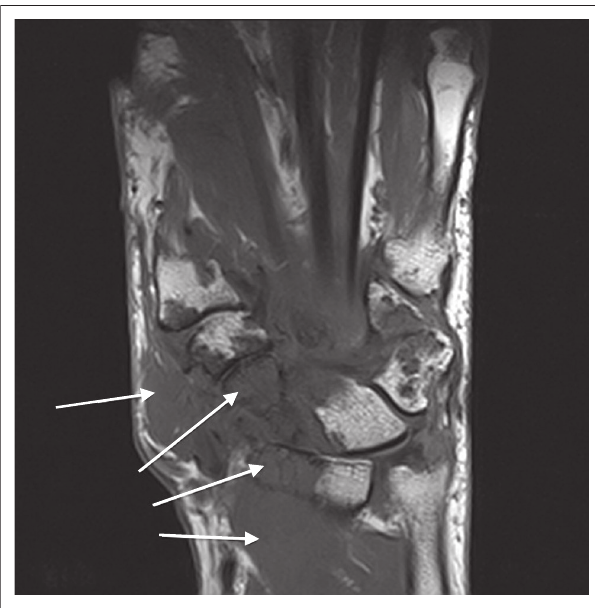
FIGURE 6: Coronal T1 FSE-weighted image shows an isointense lobulated mass in the thenar eminence with contiguous spread into the pronator quadratus, the radius, the carpal bones and the bases of the metacarpal bones (white arrows).